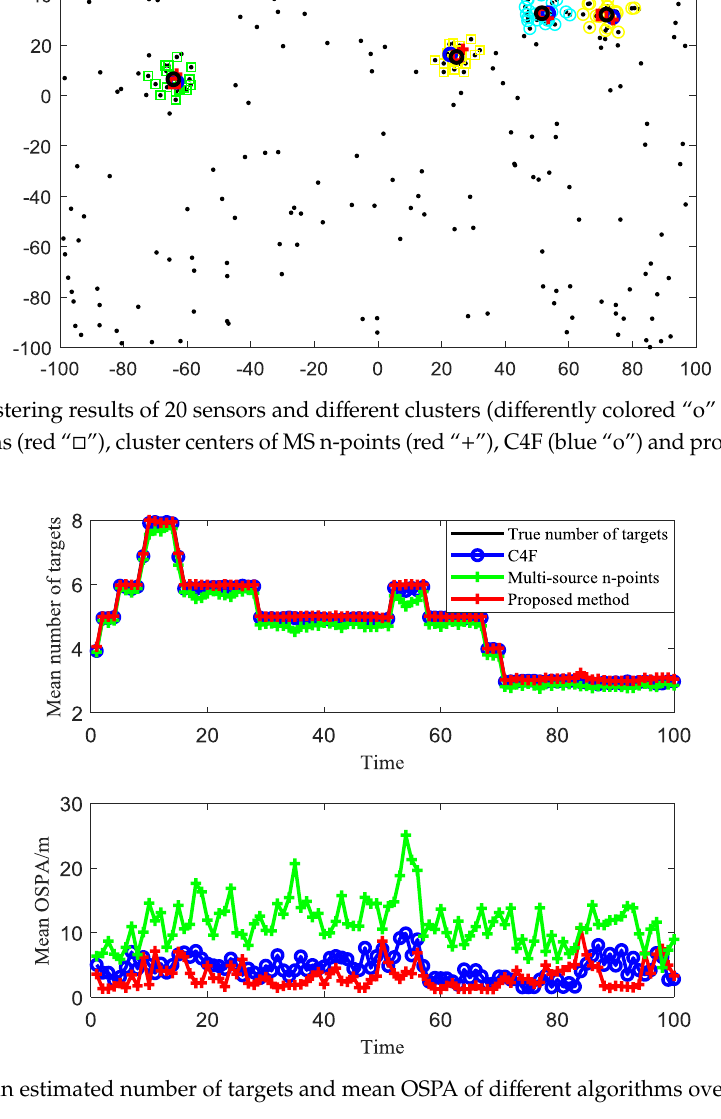
Figure 9. Mean estimated number of targets and mean OSPA of different algorithms over 20 MC trials.